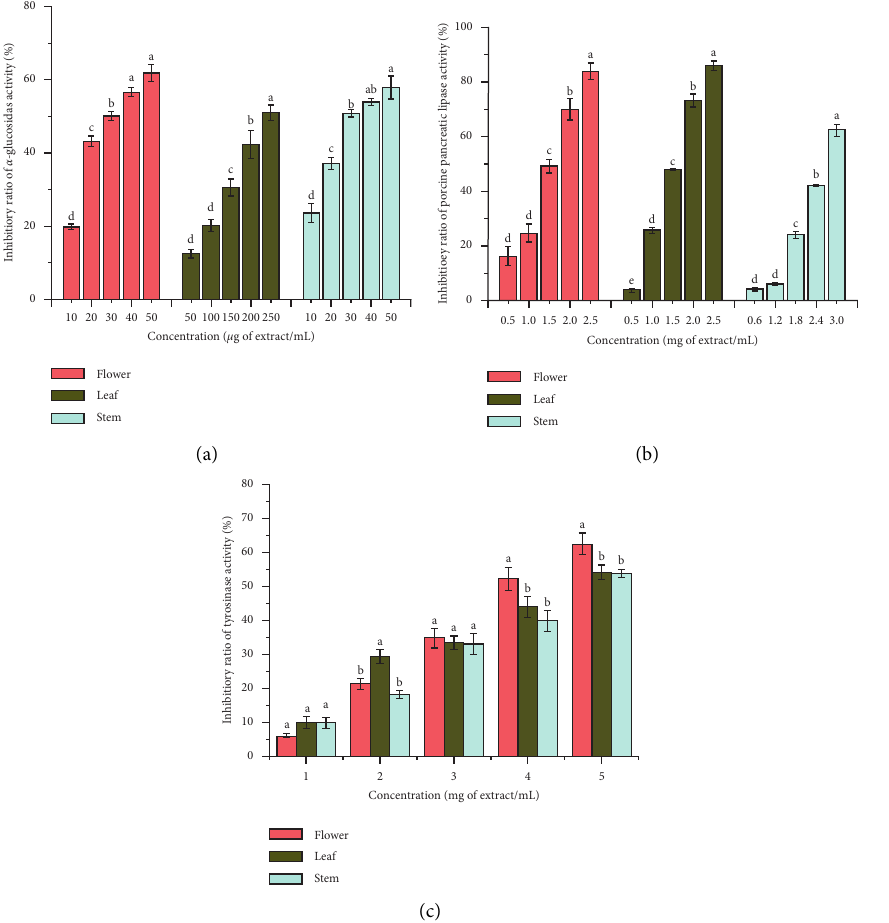
Figure 3: (a) α -glucosidase inhibitory rates, (b) porcine pancreatic lipase inhibitory rates, and (c) tyrosinase inhibitory rates of the flower, leaf, and stem extracts from Prinsepia utilis Royle. All the values are expressed as mean ± SD ( n � 3). Values with different superscript letters in each column indicate significant differences among samples ( p < 0 .